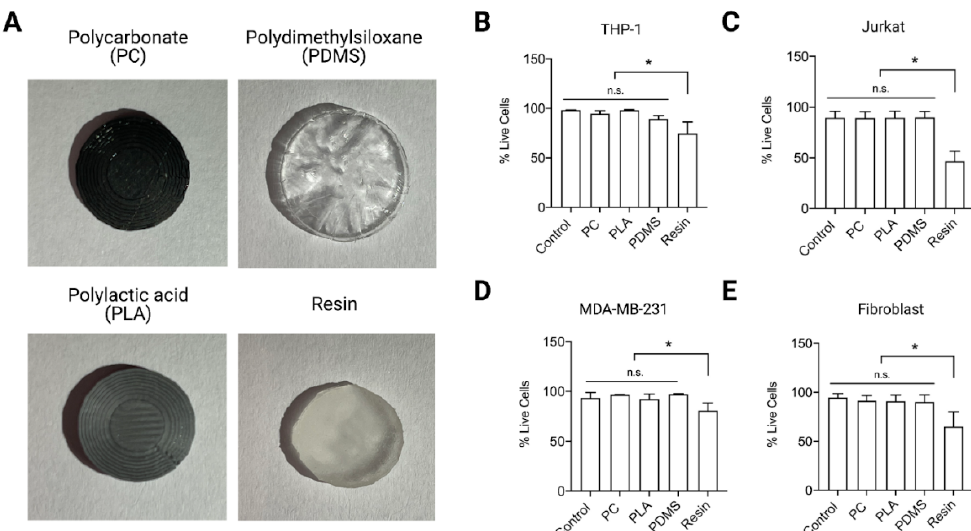
Figure 2. Material biocompatibility. ( A ) Representative images of selected materials for fabrication of cell culture microvessel. Cells were cultured on top of the materials (round disk; 13 mm in diameter) for 24 h. Biocompatibility of materials was elucidated using DRAQ7 staining, a commercial live/dead assay, for suspension cells ( B ) THP-1 and ( C ) Jurkat cells, and adherent cells ( D ) MDA-MB-231 and ( E ) primary human fibroblasts. Data are presented as mean ± SD. Experiments were performed in at least 4 replicates. n.s. indicates non significant. * indicates a P value ≤ 0.05.